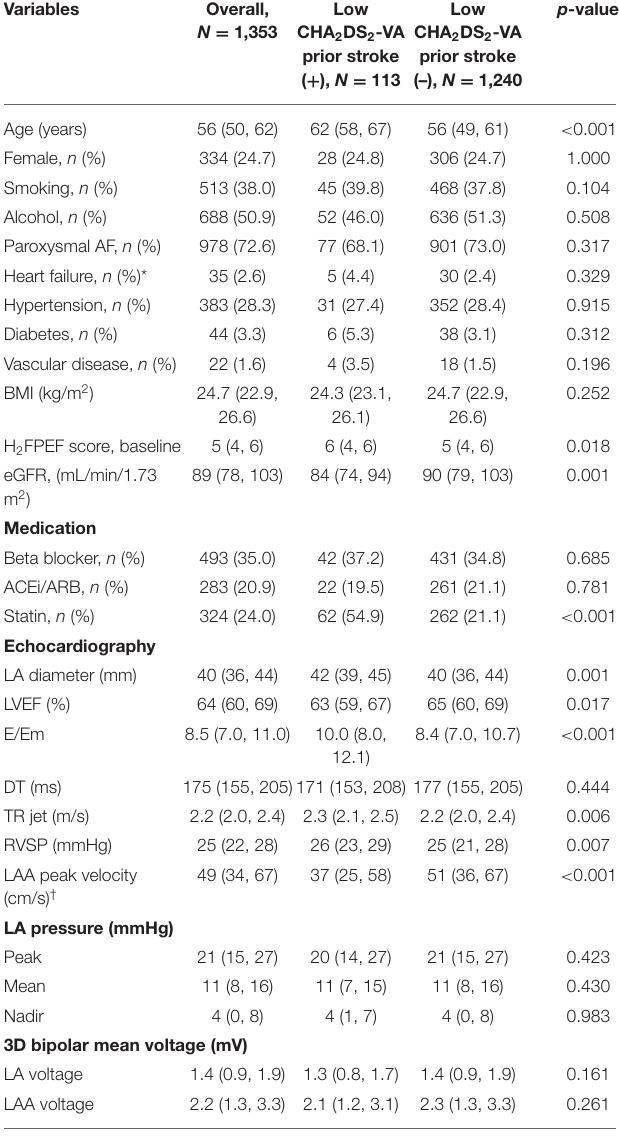
TABLE 1 | Comparison of the baseline characteristics between non-gender-related CHA 2 DS 2 -VA score 0 ∼ 1 AF patients with strokes and those without strokes.